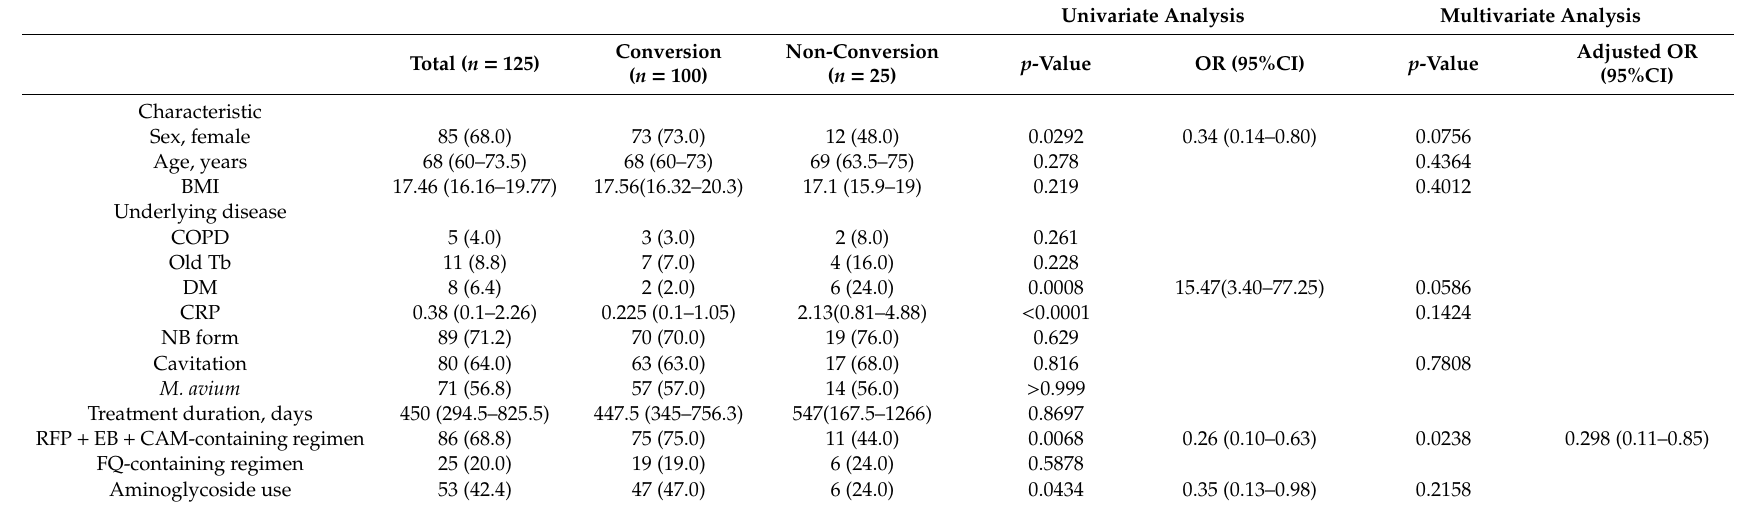
Table 2. Baseline characteristics and analysis of sputum conversion in patients with Mycobacterium avium complex pulmonary disease, no. (%) or median (IQR). Univariate Analysis Multivariate